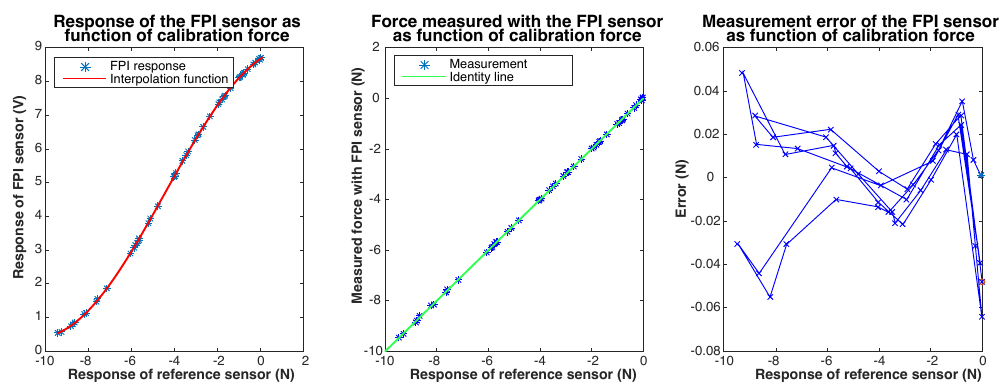
Figure 8. Results of static calibration of a prototype of the quartz capillary concept. The response of the FPI as function of the calibration force, together with a fitted sinusoidal interpolation function, is shown on the left. The center figure shows the force measured with the FPI, calculated using the interpolation function, as function of the calibration force and the indentity line ( y = x ) as a reference. The measurement error of the FPI sensor as function of the calibration force is shown on the